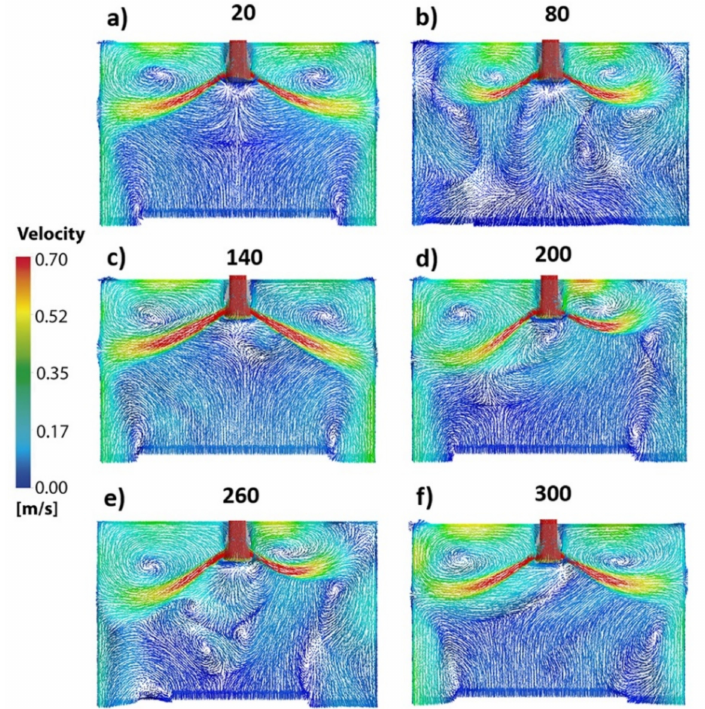
Figure 12. Numerical velocity fields in the central plane of the mold using nozzle B without clogging at different times. ( a ) 20 s. ( b ) 80 s. ( c ) 140 s. ( d ) 200 s. ( e ) 260 s. ( f ) 300